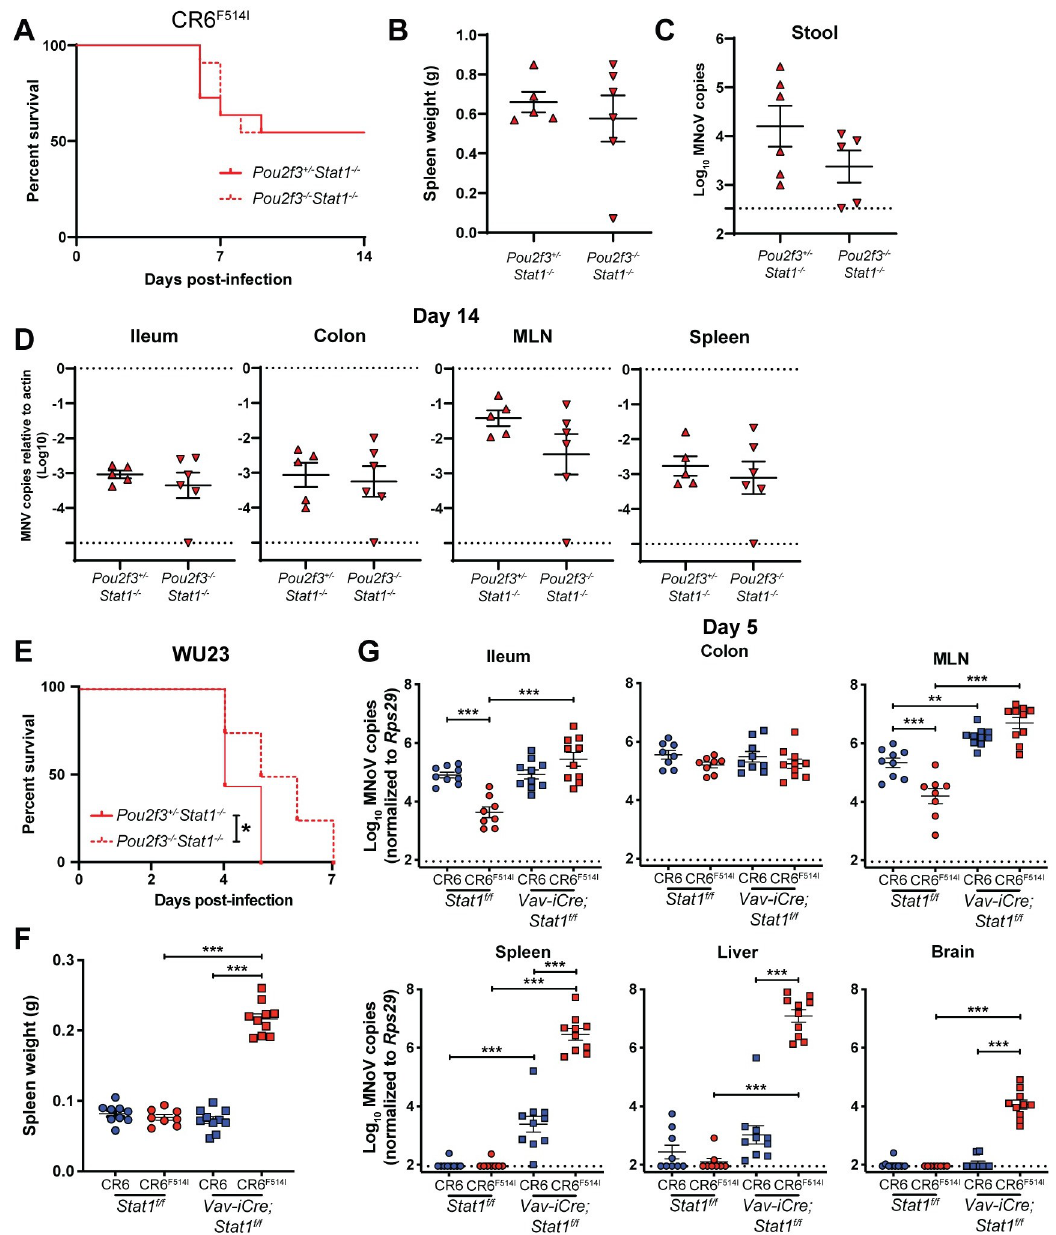
Fig 6. Tuft cells are dispensable for, but Stat1 disruption in hematopoietic cells permits, I514- or L514-associated pathogenesis. (A,B) Pou2f3 +/- Stat1 -/- and Pou2f3 -/- Stat1 -/- were orally inoculated with 10 6 PFU of CR6 F514I and analyzed for survival to 14 dpi (A) , splenomegaly (B) , stool viral levels (C) , and tissue viral levels at 14 dpi (D) . N = 11 mice per group over three independent experiments with 5–6 mice per group analyzed at 14 dpi. (E) Pou2f3 +/- Stat1 -/- and Pou2f3 -/- Stat1 -/- were orally inoculated with 10 6 PFU of WU23 and analyzed for survival to 7 dpi. N = 8–9 mice per group over two independent experiments. (F,G) Stat1 f/f or Stat1 f/f -Vav-iCre mice were orally inoculated with 10 6 PFU of CR6 or CR6 F514I and analyzed for spleen weights (F) and tissue viral levels at 5 dpi (G) . N = 8–10 mice per group over two independent experiments, with statistical analyses performed as in Fig 3 . ��� , P < 0.001; �� , P < 0.01; � , P < 0.05; ns, not significant. and T cells in gut-associated lymphoid tissue in WT mice [36], and we thus infected Stat1 f/f mice crossed to Vav-iCre (expressed in all hematopoietic cells and tuft cells) with CR6 or CR6 F514I [54,55]. Ablation of Stat1 in these cells was sufficient for CR6 F514I to confer